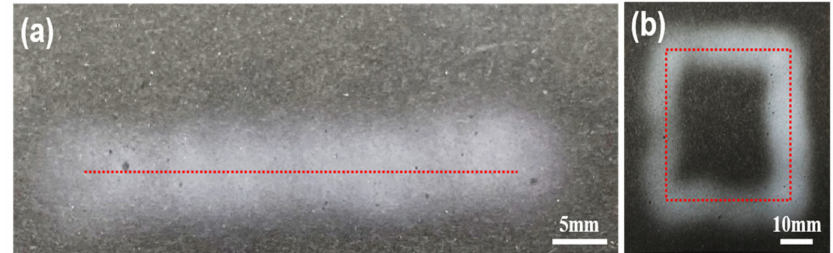
Figure 7. Electrospun nanofibers in ( a ) a line pattern and ( b ) a square